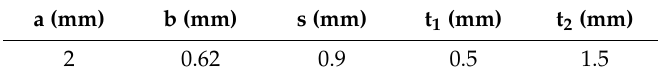
Figure 5. Cooling channel geometry and thermo–mechanical boundary conditions. Table 1. Geometric parameters of the cooling channel.